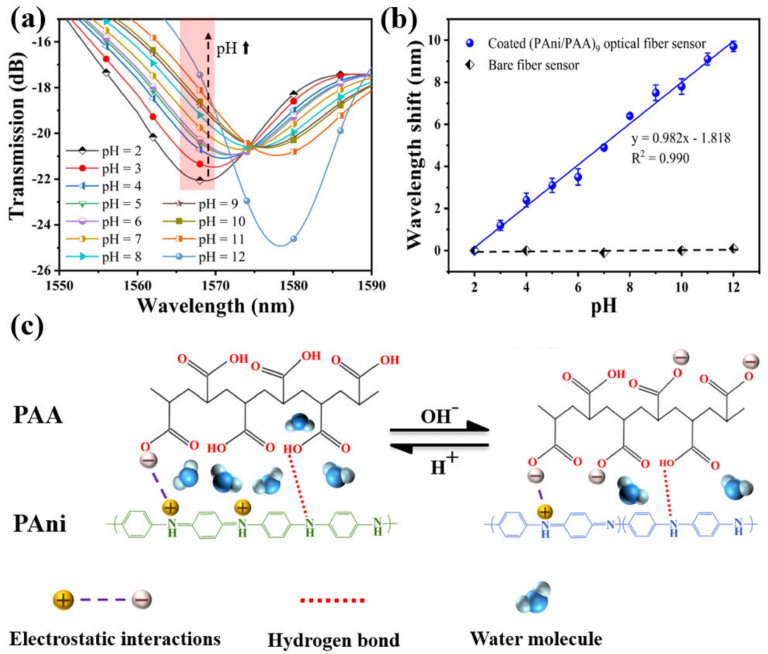
Figure 6. ( a ) Transmission spectra of the SNS sensor for different pH, ranging from 2 to 12 at 25 ◦ C; ( b ) the fitting curve between resonant wavelength shift and pH; ( c ) schematic diagram shows the pH response of PAni/PAA sensitive film.